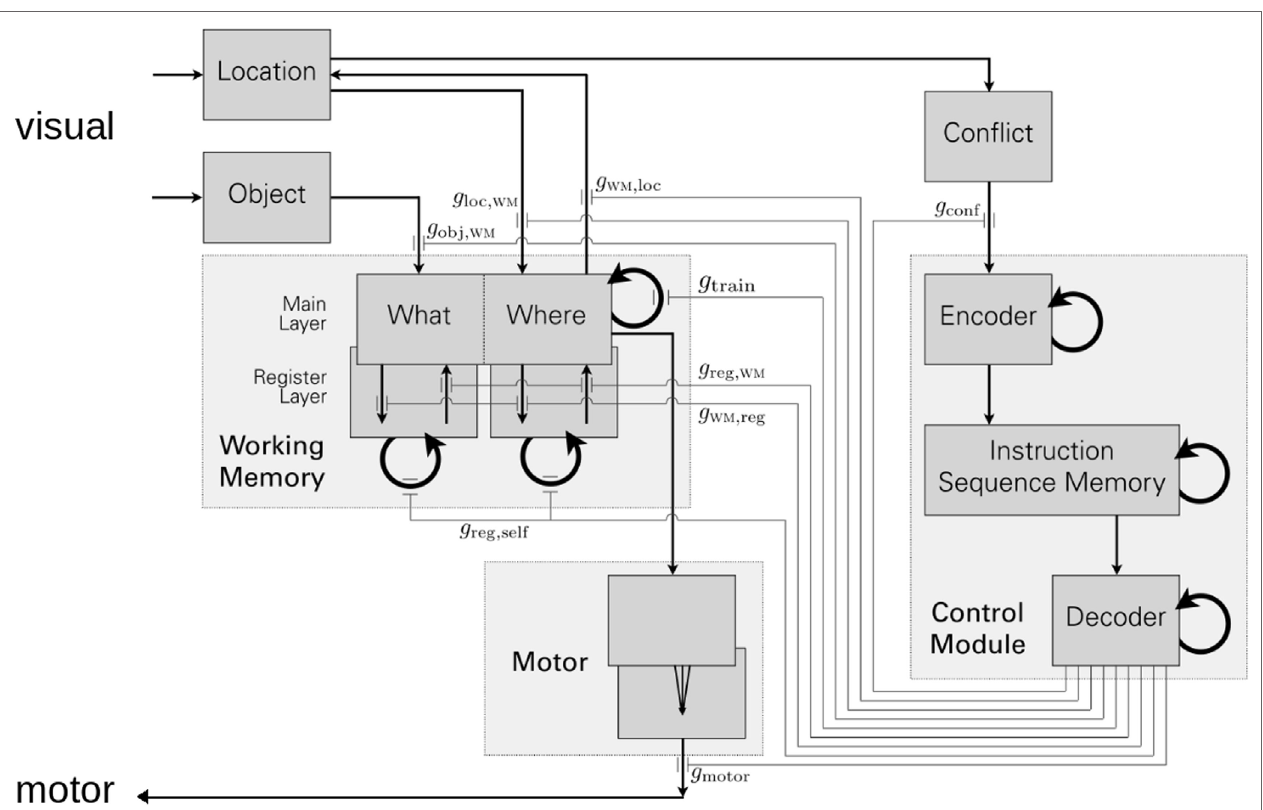
FigUre 4 | An elaboration of the details of Figure 3 above. Each rectangle with darker gray shading corresponds to a neural module, where thick semi-circular arrows indicate recurrently connected networks. Thin arrows indicate the connectivity between modules. The working memory of Figure 3 is depicted on the left, while the executive system (control module) is shown on the right. The connections leaving the decoder module at the lower right of the illustration implement gating actions as explained in the main text. Figure from Sylvester and Reggia